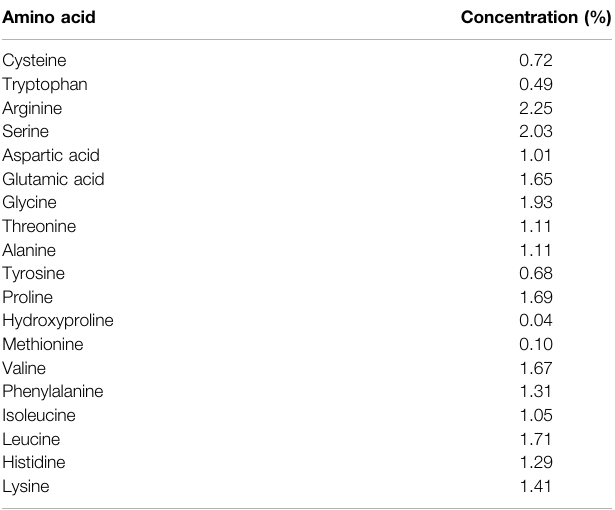
TABLE 1 | Amino acid pro fi le of the chicken feathers hydrolysate. Amino acid Concentration